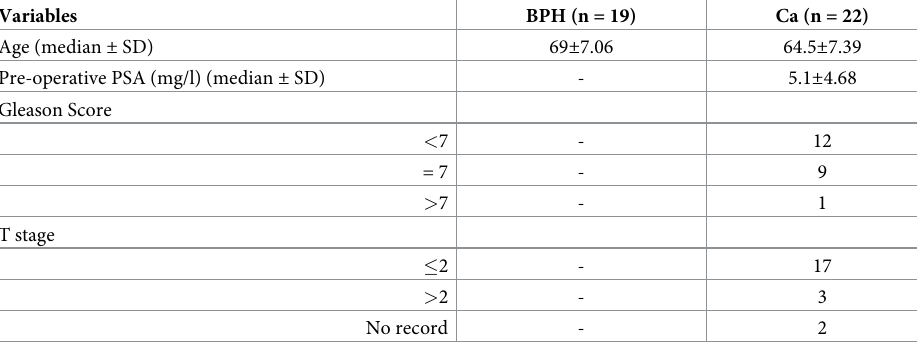
Table 1. Patient characteristics of cohort of specimens at SFVAHCS for IHC